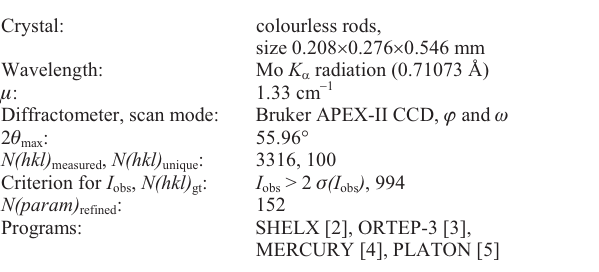
Table 1. Data collection and